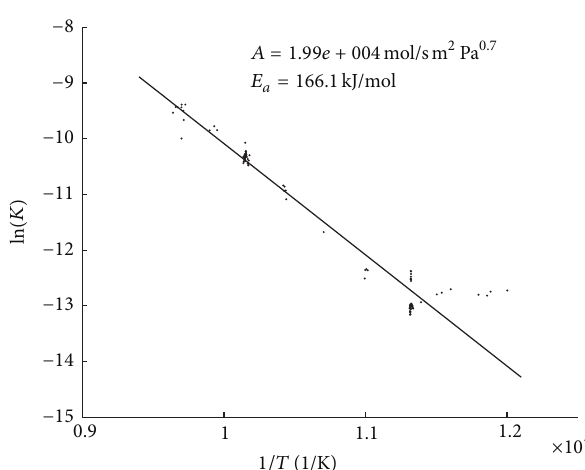
Figure 5: Arrhenius plot for measured rate constants on the quarter cell